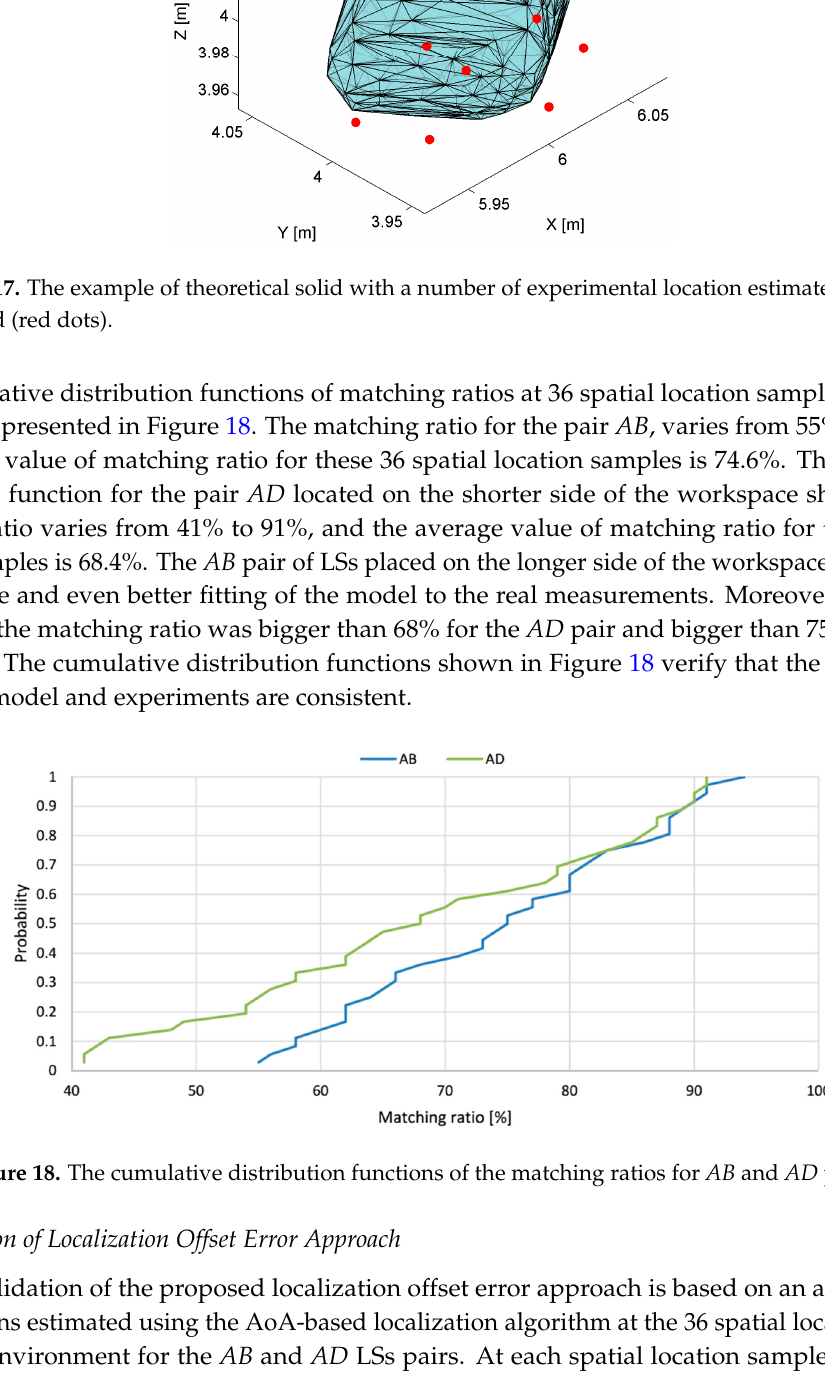
Figure 18. The cumulative distribution functions of the matching ratios for AB and AD pairs.